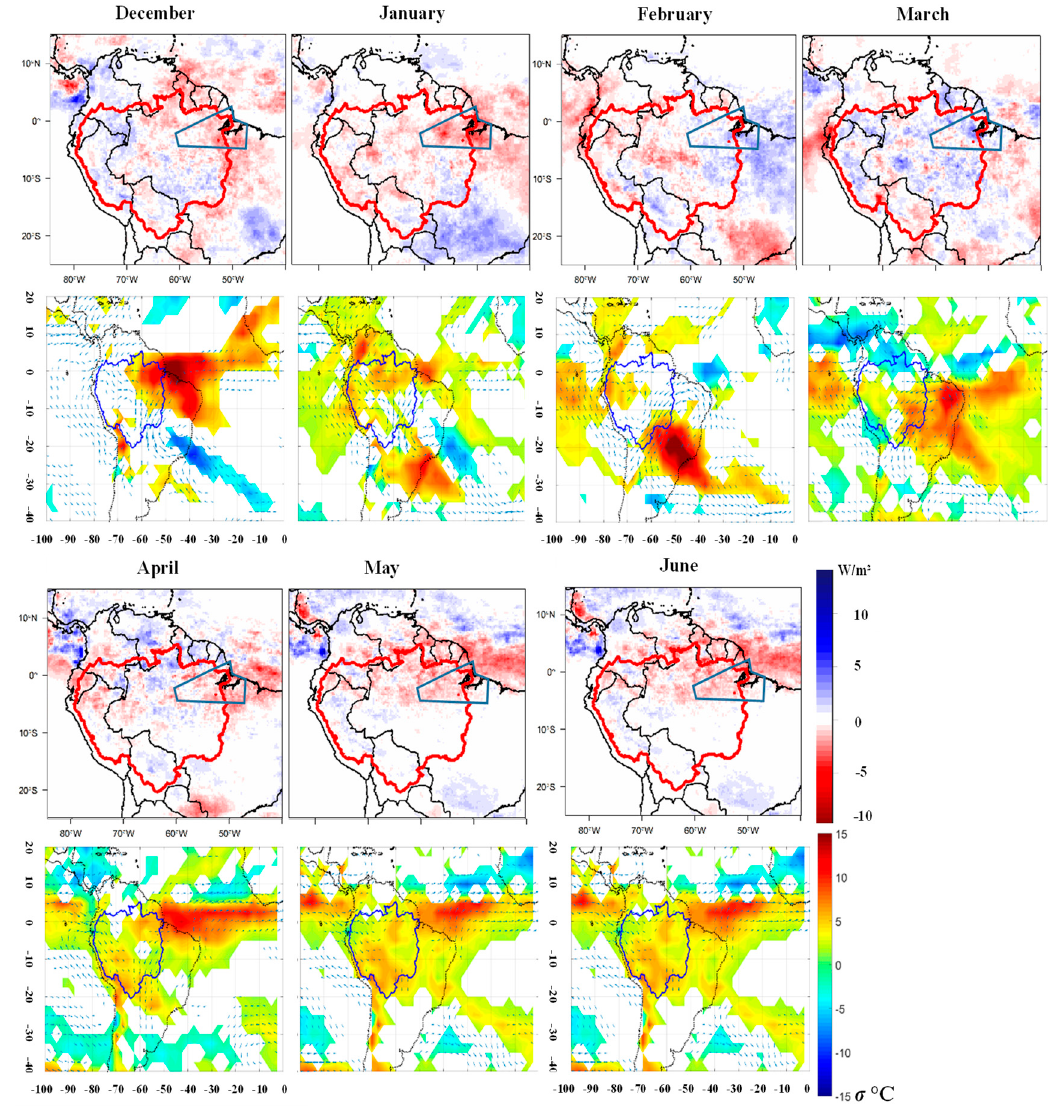
Figure 12. Monthly composite maps of 3B42 grid normalized monthly anomalies ( top ) and OLR and water vapor flux monthly significant anomalies ( bottom ). Anomalies are computed based on cluster Cl1 years in the northeastern region. The blue polygon represents the northeastern region of the AB.